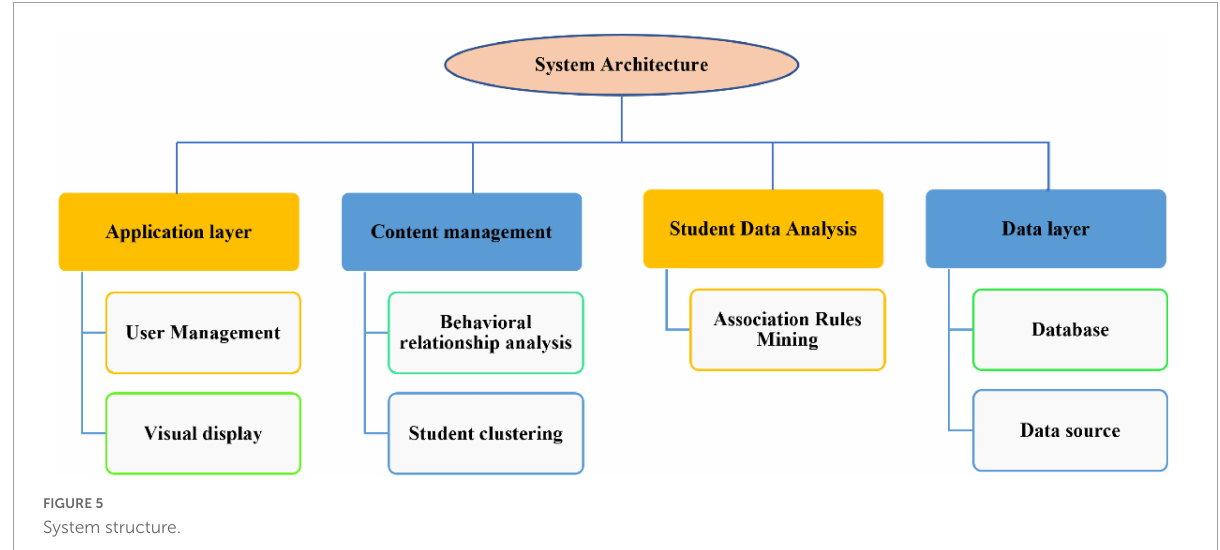
FIGURE5 System structure.